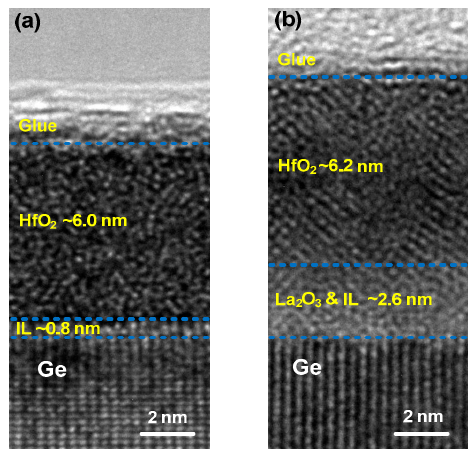
Figure 3. Cross-sectional HRTEM images showing the interfaces with Ge substrates for ( a ) the control sample; ( b ) sample S4 with 15 ALD cycles of La 2 O 3 passivation layer.